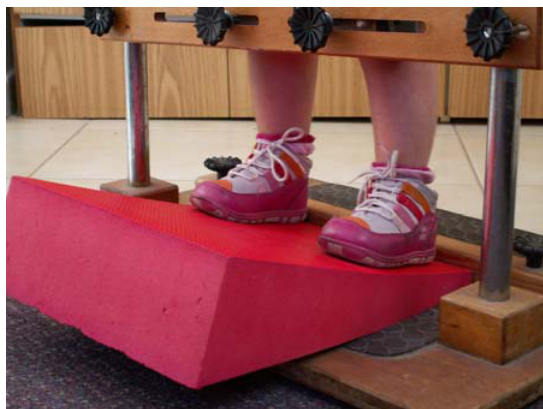
PICTURE 15. A child standing on a